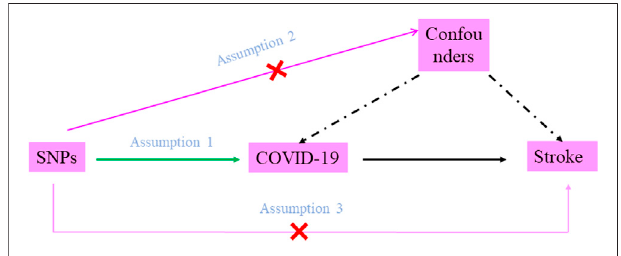
FIGURE 1 | Diagram of two-sample Mendelian randomization analysis. Assumption 1: the SNPs should be associated with COVID-19 susceptibility or severity; Assumption 2: the selected SNPs should be independent of confounders; Assumption 3: the SNPs should affect stroke only via COVID-19 susceptibility or severity rather than via a direct